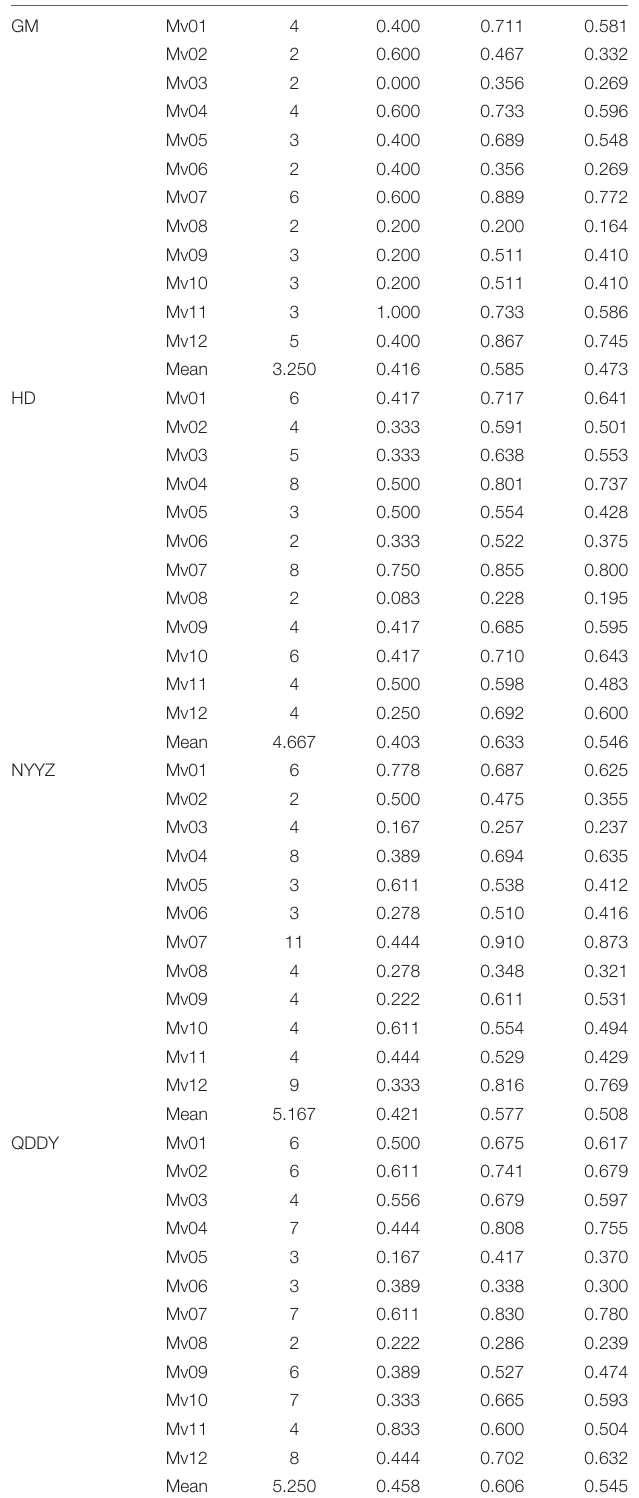
TABLE 5 | Genetic information for the 12 microsatellite loci observed in M. vulgaris . Population